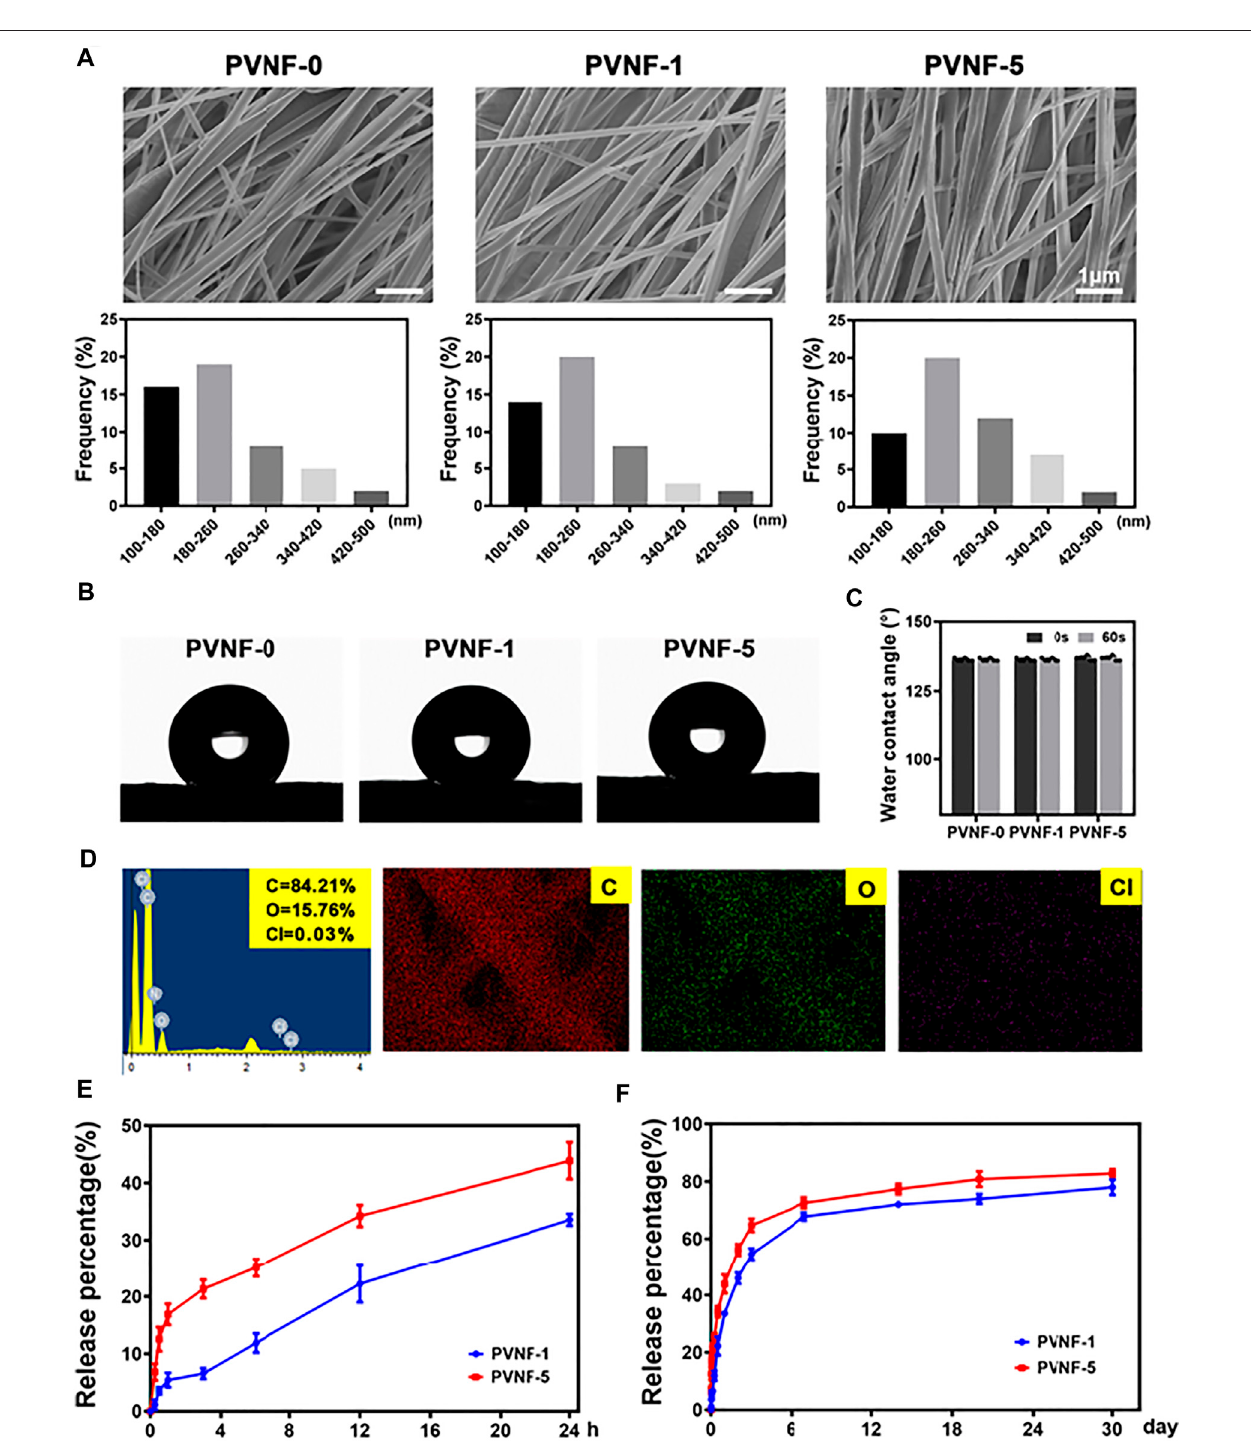
FIGURE 3 | (A) SEM images and diameter distribution of PVNF-n ( n (cid:1) 0, 1, and 5, respectively). (B, C) Representative images and statistical results of the water contact angle ( N (cid:1) 5). (D) EDS spectrum and elemental mapping of PVNF-5. (E, F) Drug release kinetics of the PVNF-1 and PVNF-5 samples ( N (cid:1) 5). Scale bar: 1 µm.